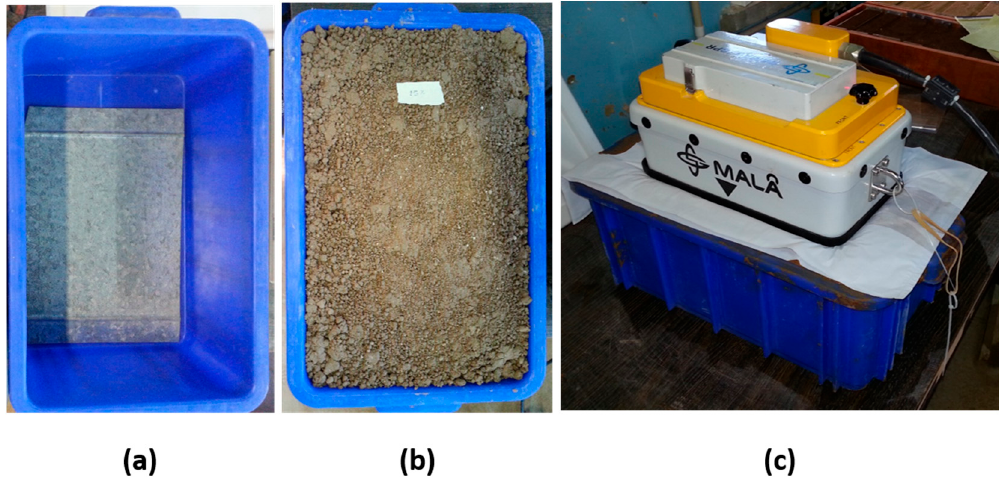
Figure 2. Ground-penetrating radar (GPR) laboratory calibration experiments in 21 L plastic soil boxes. ( a ) Metal plate at the bottom; ( b ) loess soil, mixed manually (15% volumetric soil moisture content (VSMC) added in steps of 5%); ( c ) 800 MHz antenna in static measurement position.